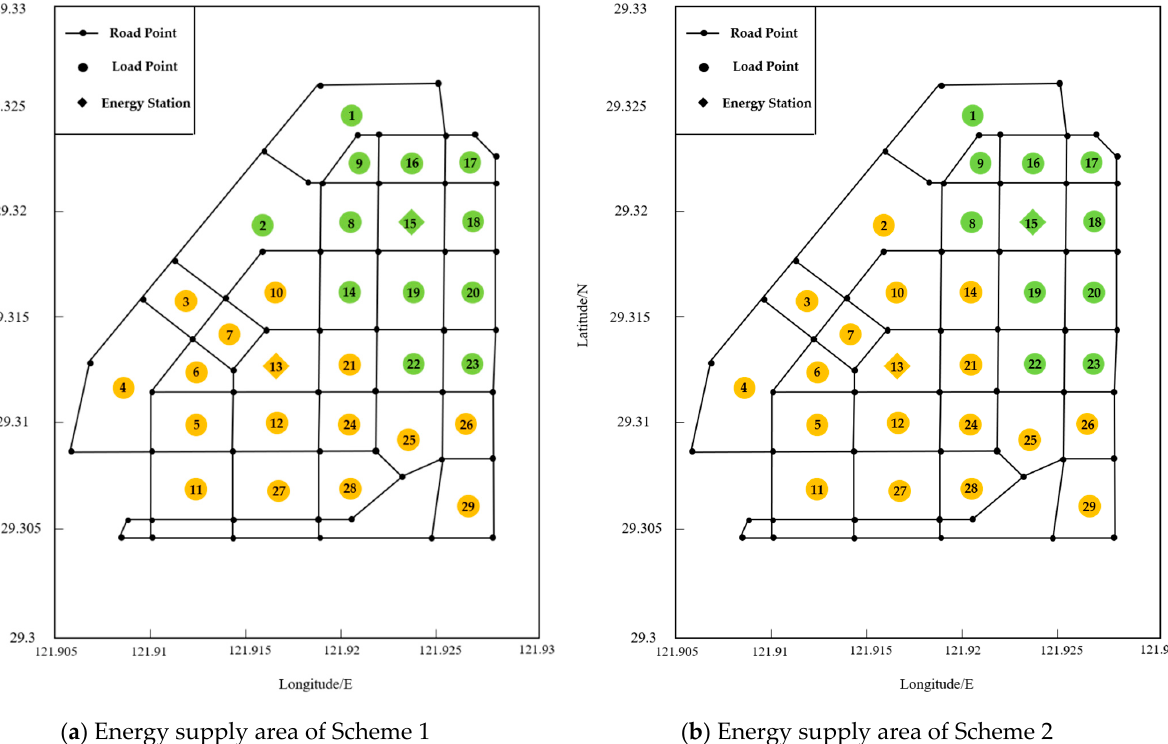
10 of 16 Table 1. Table of simulation parameters. Parameters